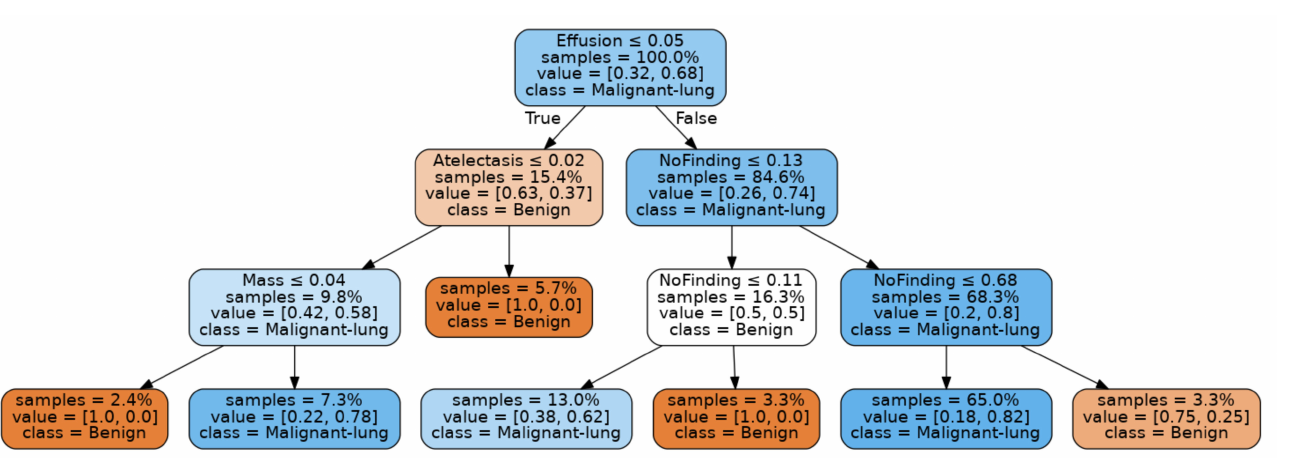
Figure 11. Decision tree fitting best result from JSRT